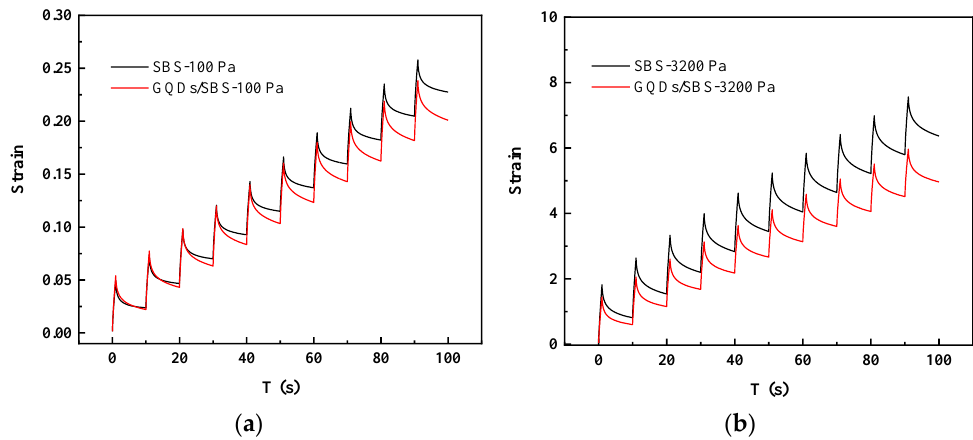
Figure 11. Strain response of SBS-modified asphalt and GQDs/SBS composite-modified asphalt ( a ) in 10 cycles at 60 °C 100 Pa and ( b ) in 10 cycles at 60 °C 3200 Pa.